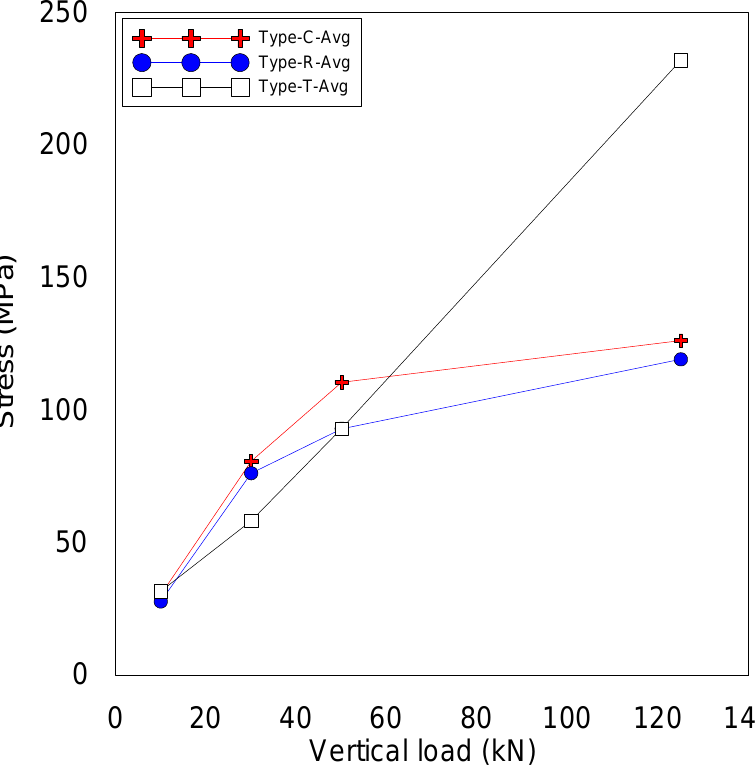
Figure 13. Averaged stress – vertical load curves.